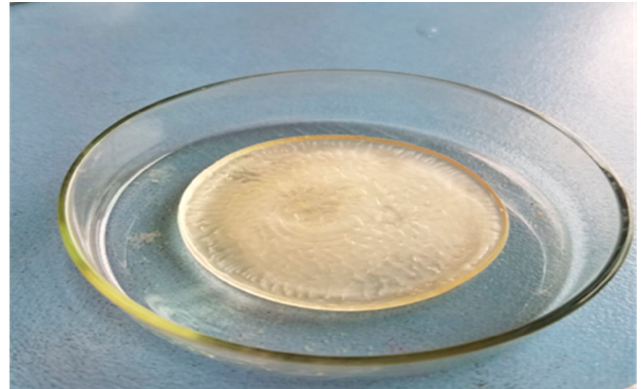
Figure 1. Fabricated polymeric cross-linked hydrogel topical patch.